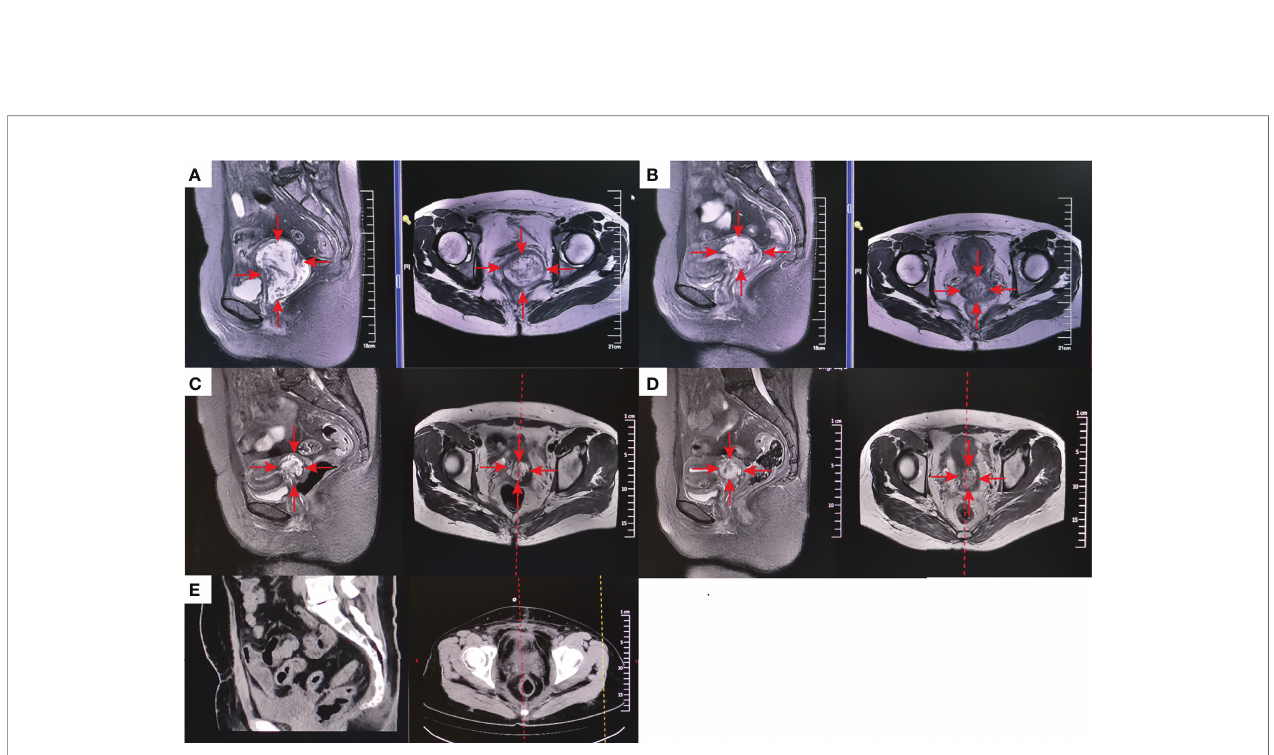
FIGURE 3 | A patient with stage IB3 at the initial diagnosis of mucinous adenocarcinoma of the cervix developed into a huge residual mass of 57*76*66mm (MRI) (A) because of the treatment was terminated by grade 4 myelosuppression due to one cycle of neoadjuvant chemotherapy, which also made the patient refuse concurrent chemotherapy. After external-beam radiotherapy (EBRT) 30Gy plus 1 cycle local injection of H101 (1.0×10 12 virus particles daily for 5 days), the mass was signi fi cantly reduced to 46*51*48mm (MRI) (B) . The mass was further reduced by 32*46*45mm (MRI) (C) after 50Gy of EBRT. After the following brachytherapy (6Gy for 1 time of intraluminal brachytherapy and 7Gy for 3 times of interstitial brachytherapy), the residual lesion was 29*39*30mm (MRI) after 1 month of radiation (D) . Since refusal of chemotherapy, she accepted 1 cycle treatment of H101 (5.0×10 11 virus particles daily for 5 days) again. Gynecological examination indicated that the lesion had further shrunk, while there were still some suspicious and hard masses. Therefore, surgical resection of the residual lesion was suggested. Postoperative pathology indicated that no cancer cells were found in the surgically excised lesions. One-month postoperative Computed tomography (CT) scan showed no signs of tumor (E) . The red arrow stands for the tumor